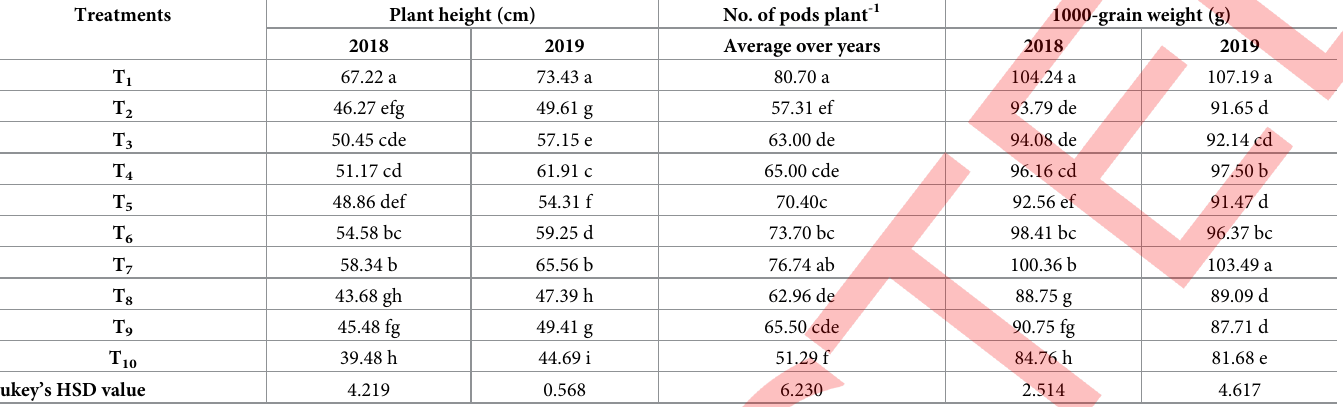
Table 1. The impact of interference of horse purslane and other weeds on plant height, number of pods plant -1 and 1000-grain weight of soybean during 2018 and 2019.